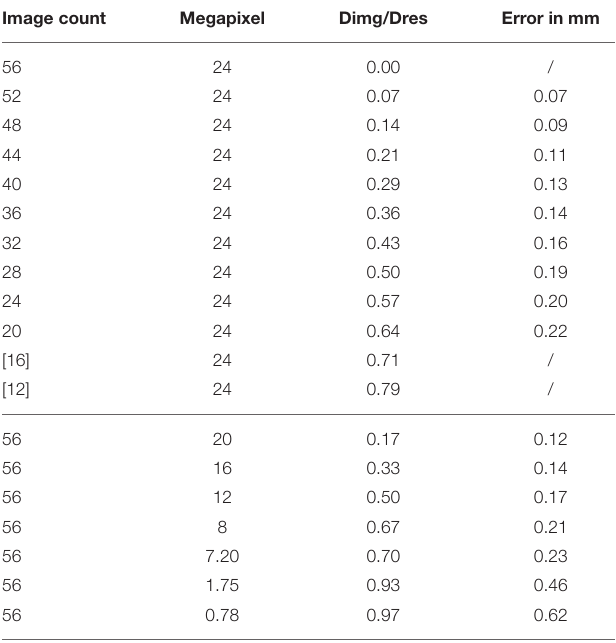
TABLE 1 | Overview